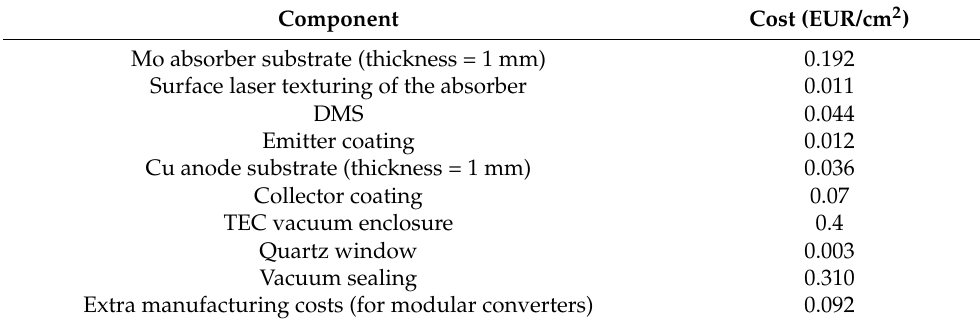
Table A3. List of the estimated prices for each sub-component of the TEC.